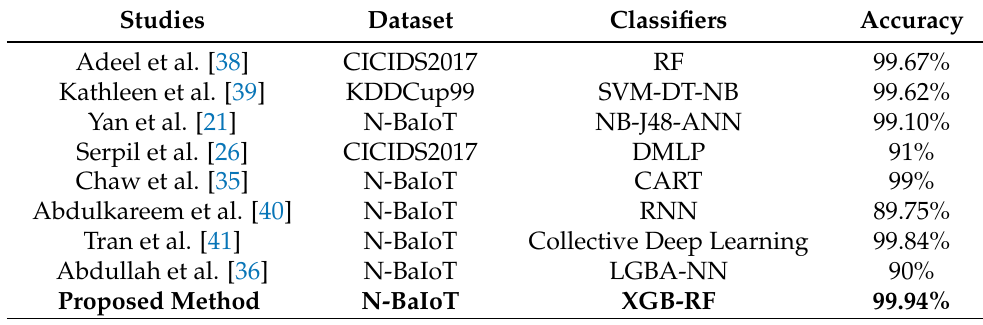
Table 5. Performance Comparison with Other